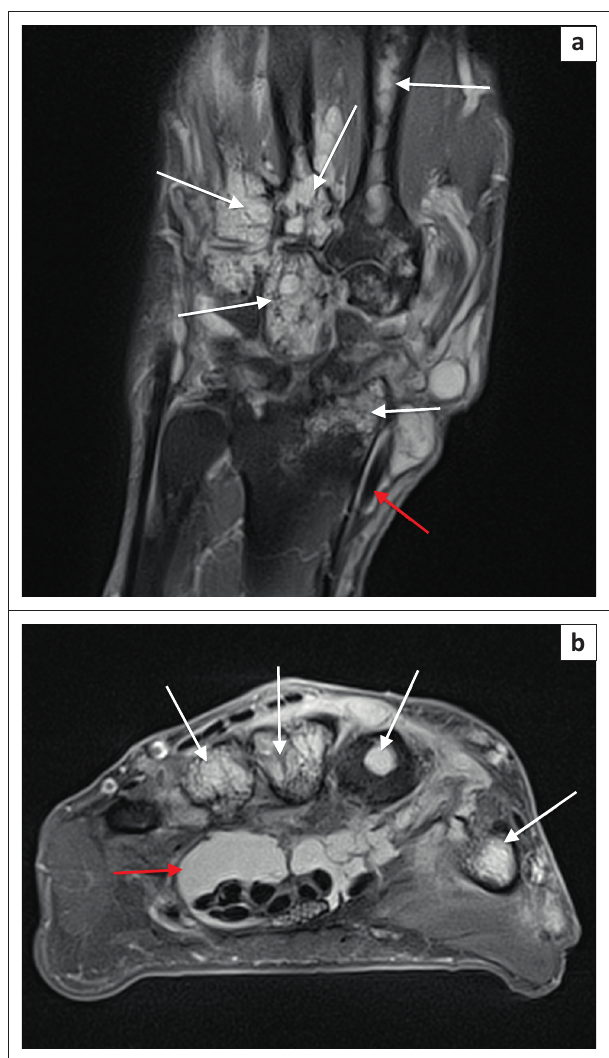
FIGURE 8: Coronal (a) and axial (b) PD fat-saturated images with marked flexor and extensor compartment tenosynovitis (red arrows) and large hyperintense erosions in the radius, carpal and metacarpal bones (white